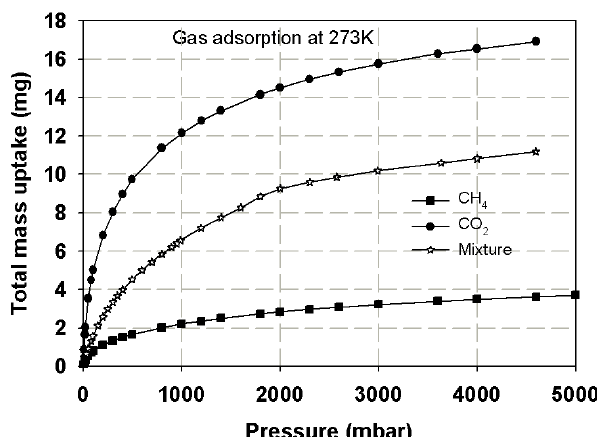
Figure 8. Adsorption isotherms of methane, carbon dioxide and their mixture in LAC1 activated